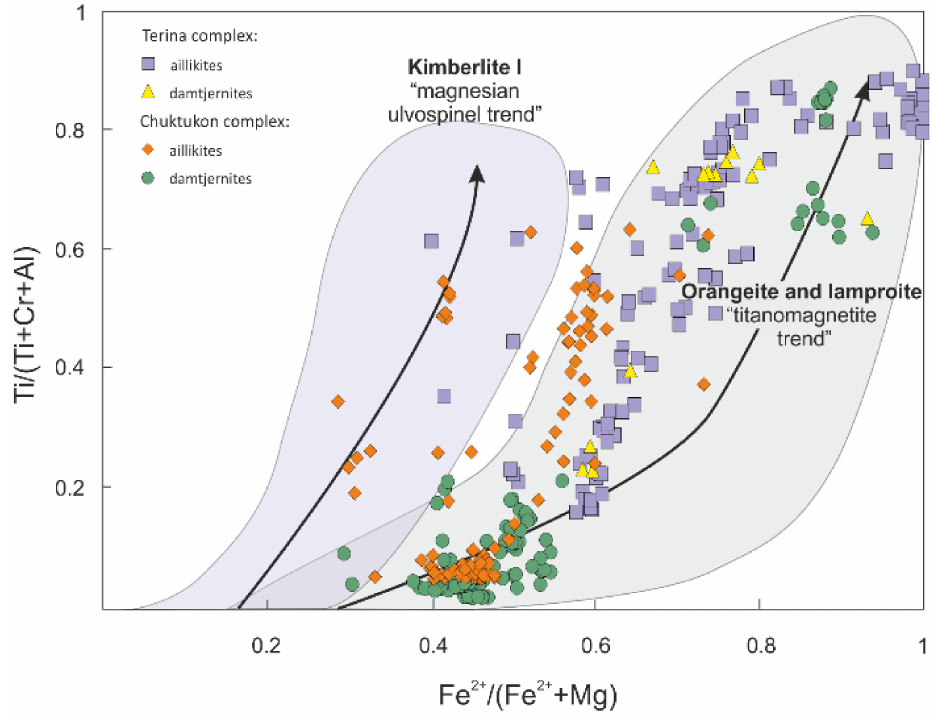
Figure 5. Plot of atomic ratios Ti/(Ti + Cr + Al) and Fe 2+ /(Fe 2+ + Mg) for minerals of the spinel group